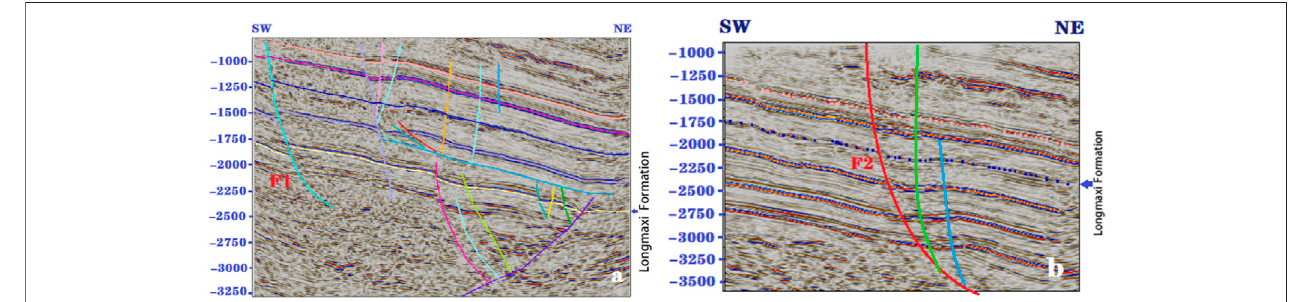
FIGURE 5 | Early Yanshanian structural reverse fault (Corresponding to the plane F1 reverse fault and F2 reverse fault formation).